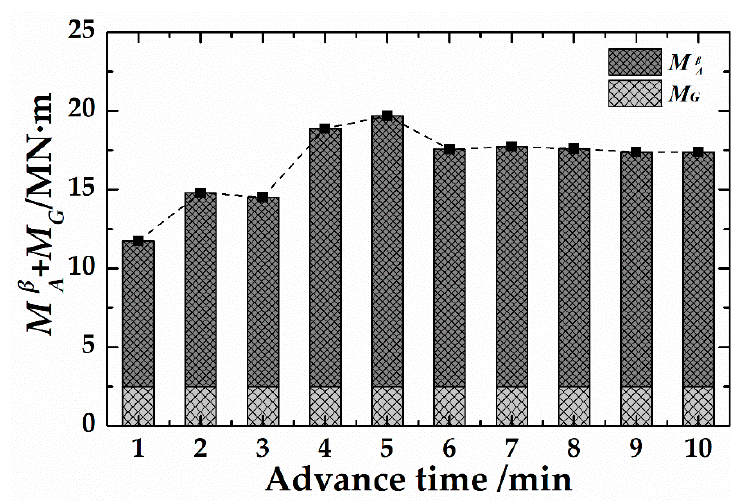
β + M β β + M G. + M A G. G . A A